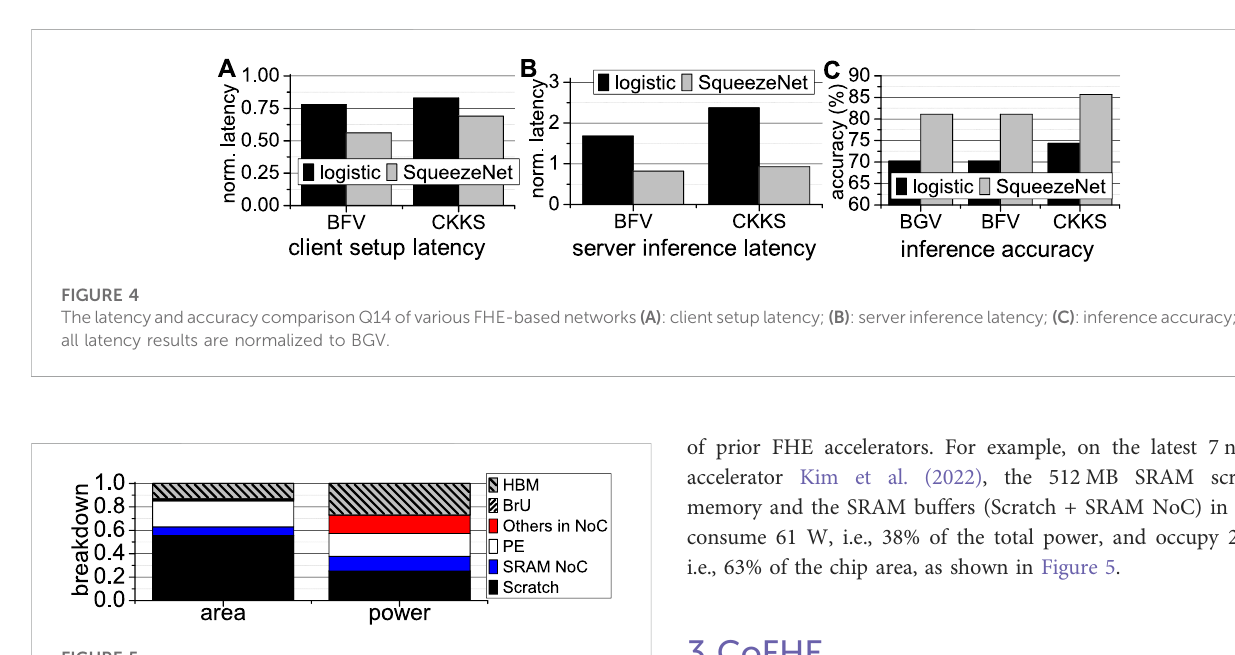
FIGURE 5 The SRAM scratchpad and NoC SRAM buffers of a prior FHE accelerator Kim et al.